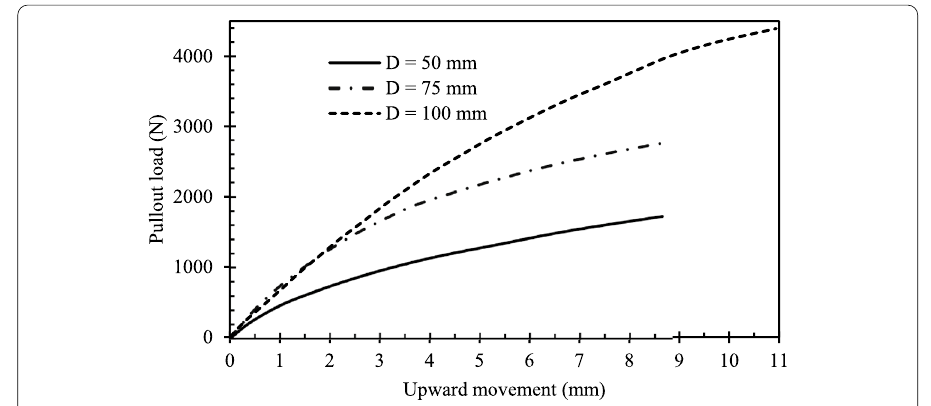
Fig. 9 Pullout behaviour of GPA with L / D